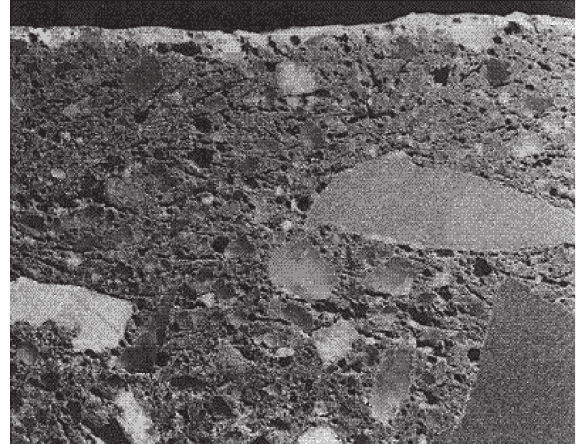
Figure 12: Outer layer of a concrete element: aggregates remain 5–10mm approx. far from the surface. 5x